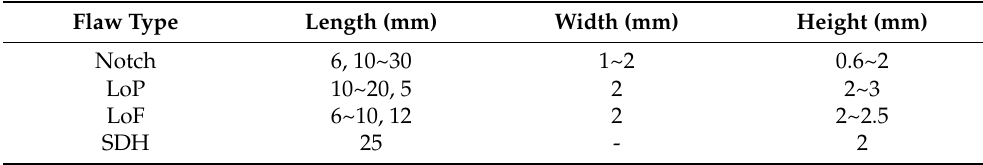
( b ) Figure 20. Angles for each inspection position on the experimental welding test pieces: ( a ) 100 mm curvature pipe with elbow – flange construction geometry; ( b ) 75 mm, 100 mm curvature pipe with elbow – flange – reducer construction geometry. Figure 21 shows the amplitude comparison between a total of 17 flaws on the flange – elbow – elbow specimen. A relatively small 4 MHz probe and the FPAPr were used for the flange – elbow – elbow specimen with a large curvature and a small outer diameter (OD). The bidirectional inspection was performed in the experiment, but the general probe was only able to inspect one side due to the curvature at the bending near the flange – elbow (0 ° ) and the overall area of the elbow – elbow. Therefore, low sensitivity at the flaw and flaw detection failure was observed in Figure 21a (7) and Figure 21b (4) and (8), respectively.